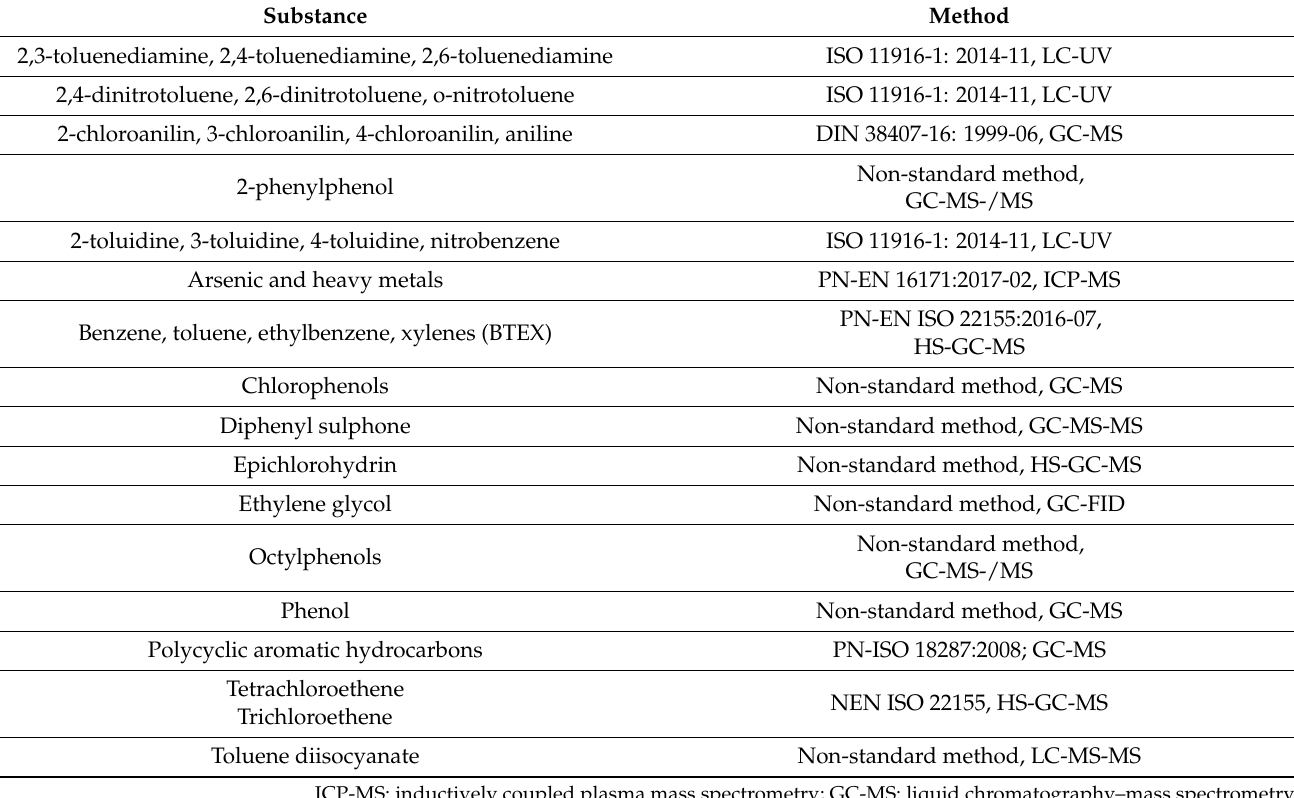
Table 4. Analytical methods applied for the determination of